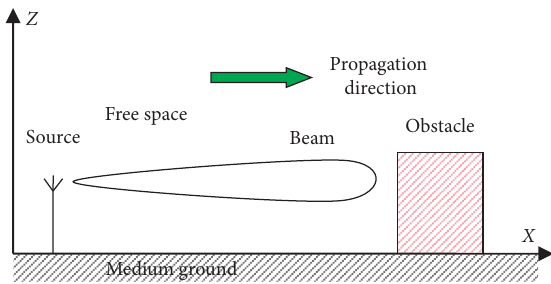
Figure 1: Schematic diagram of wave propagation